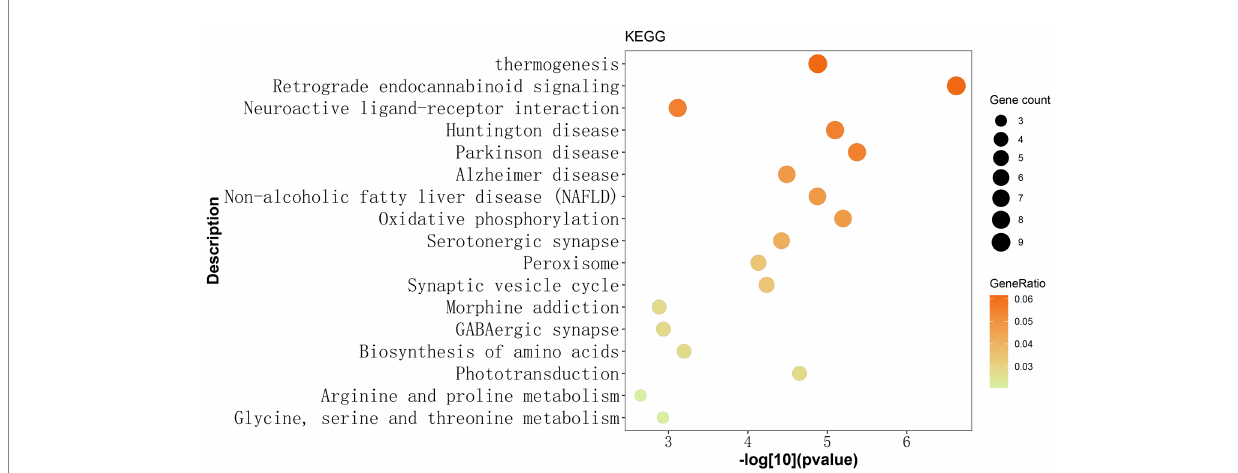
FIGURE 1 Identified 17 KEGG pathways based on 146 gene mutations observed exclusively in Chinese patients with MDD. The y-axis represents the KEGG pathway term, while the x-axis shows the -log[10]( p -value). Each dot on the plot represents the fold enrichment for each KEGG pathway. The size of each dot corresponds to the number of mutated genes related to the depression phenotype, and the color of each dot represents the proportion of enriched genes in that pathway relative to the total number of mutated genes. The darker color indicates a higher proportion of genes. The retrograde endocannabinoid signaling pathway exhibited the most significant enrichment among the 17 KEGG pathways. KEGG: Kyoto Encyclopedia of Genes and Genomes.